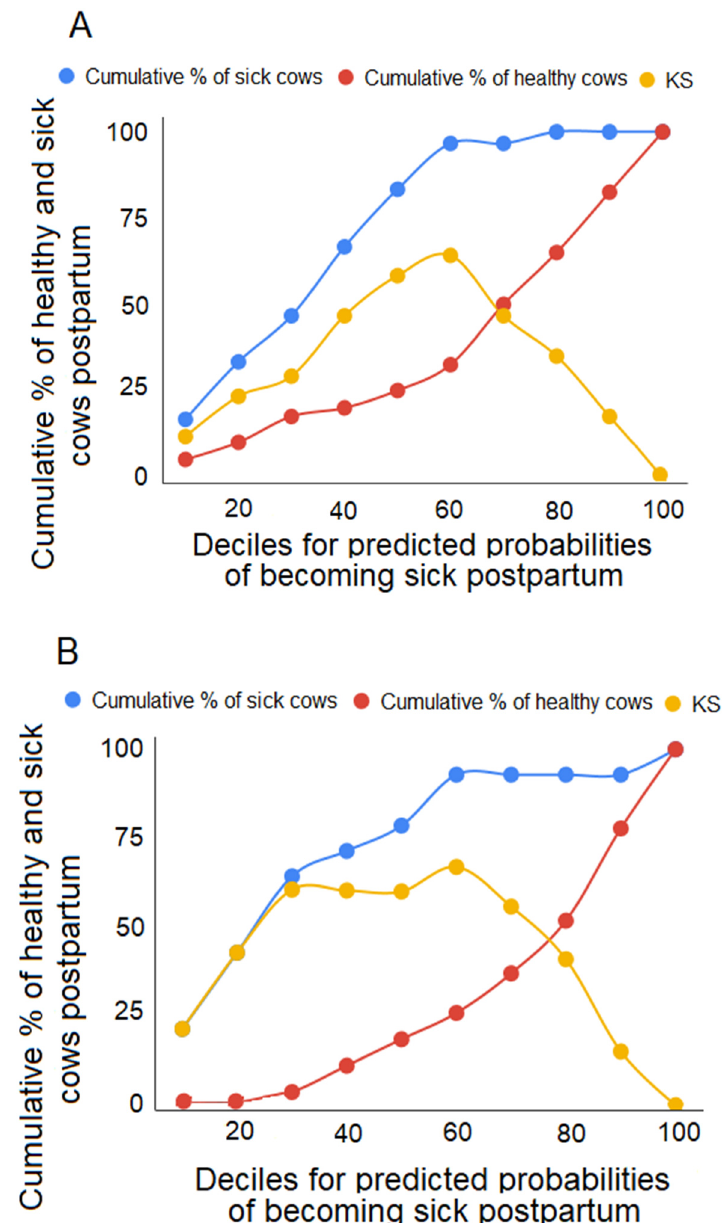
Figure 3. These Kolmogorov Smirnov (KS) graphs for multiparous ( A ) and primiparous ( B ) cows, calculated based upon the individual predicted probabilities of the logistic regression model. The blue lines and red lines indicate the cumulative percentage of sick 1 and healthy 2 cows in each decile, and the yellow lines represent the associated KS statistic (calculated as the difference between the cumulative percentages). 1 Cows that became sick with at least one disease (ketosis, metritis, or mastitis) during the postpartum period. 2 Cows that did not develop ketosis, metritis, or mastitis during the postpartum period.